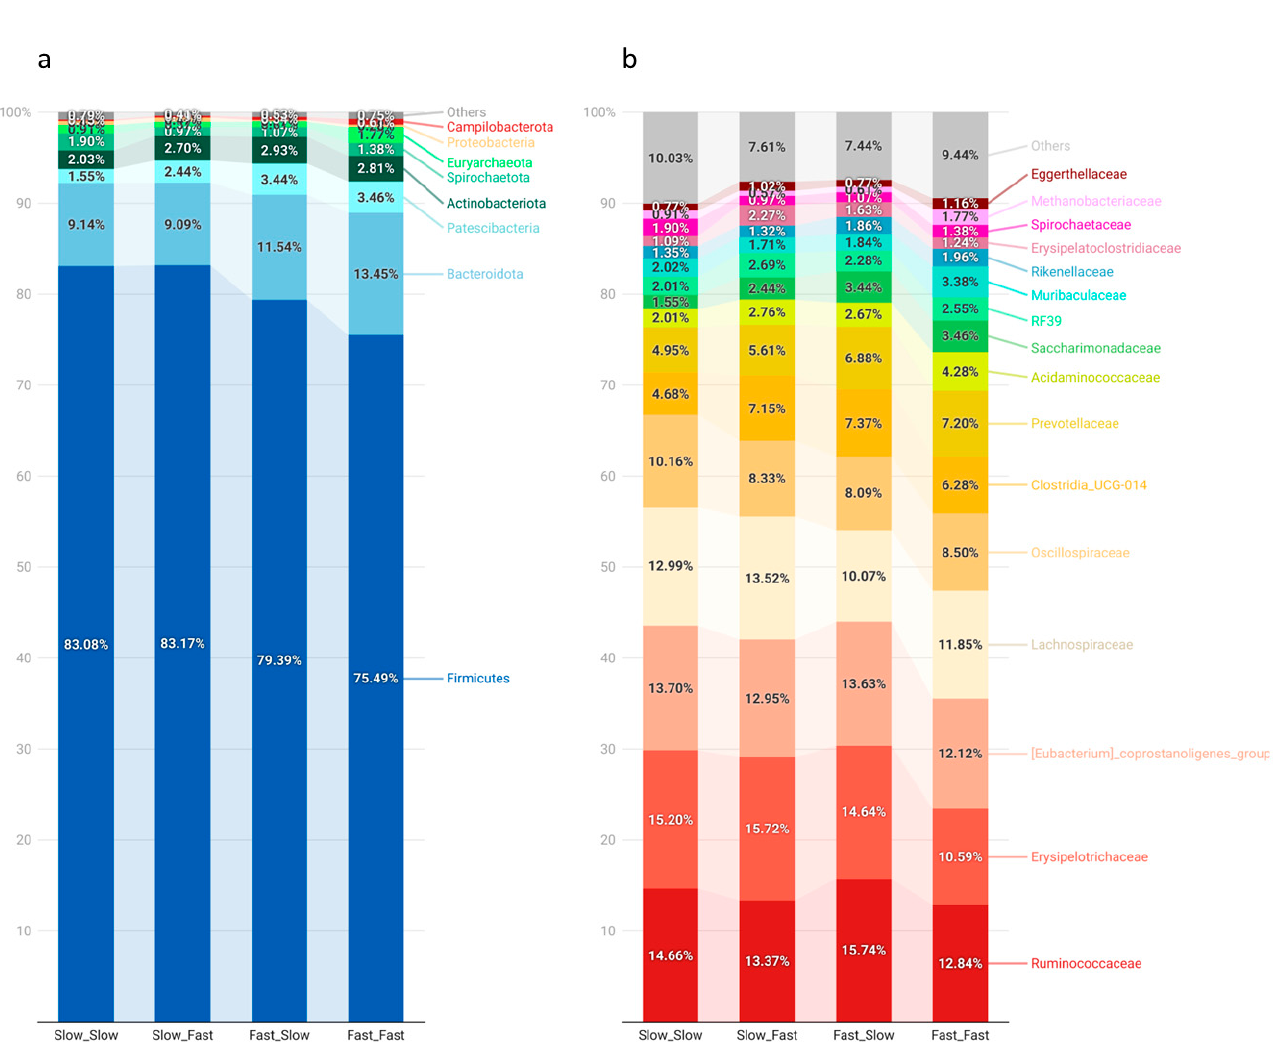
Figure 2. Relative abundances (RA) of the main phyla ( a ) and families ( b ) observed in the analysis of the microbiota of piglets by massive sequencing of the 16S rRNA gene. The figure was created with the online open-source tool Datawrapper (http://datawrapper.de; accessed on 2 November 2022). Fast_Fast: pigs showing fast growth during the lactation and nursery periods ( n = 19), Fast_Slow: pigs showing fast growth during the lactation period and slow growth during the nursery period ( n = 18, missing samples = 1), Slow_Fast: pigs showing slow growth during the lactation period and fast growth during the nursery period ( n = 17, missing samples = 2), and Slow_Slow: pigs showing slow growth during the lactation and nursery periods ( n = 17, missing samples = 1).